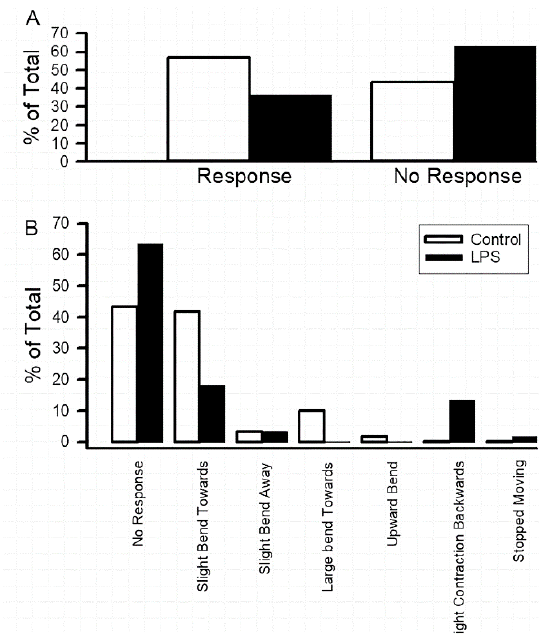
Figure 3. Responses to light mechanosensory touch. The behaviors were devised into an ethogram based on the observed responses. Examining if there was a response or not to the stimulus revealed a decrease in responsiveness in LPS-fed larvae ( A ) (N = 20). In sub-dividing the behavioral repertoire into the observed behaviors, the slight bend and strong bend toward the stimulus were the responses most notably decreased in the LPS-fed larvae ( B ). The response to the back up (i.e., inchworm backwards) was increased in the LPS-fed larvae when touched ( B ). The other observed behaviors did not occur often enough for strong observational di ff erences from the control larvae. (File